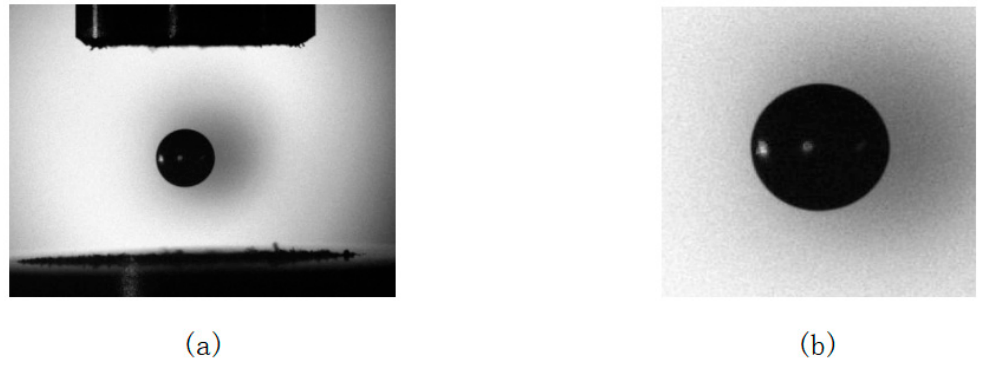
Figure 4. Metal droplet datasets. ( a ) HR image, ( b ) HR image after cropping.